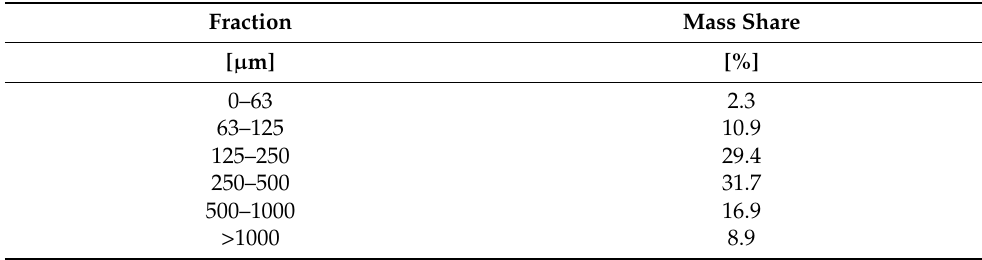
Table 5. Test substance composition/road-deposited sediments (RDSs).